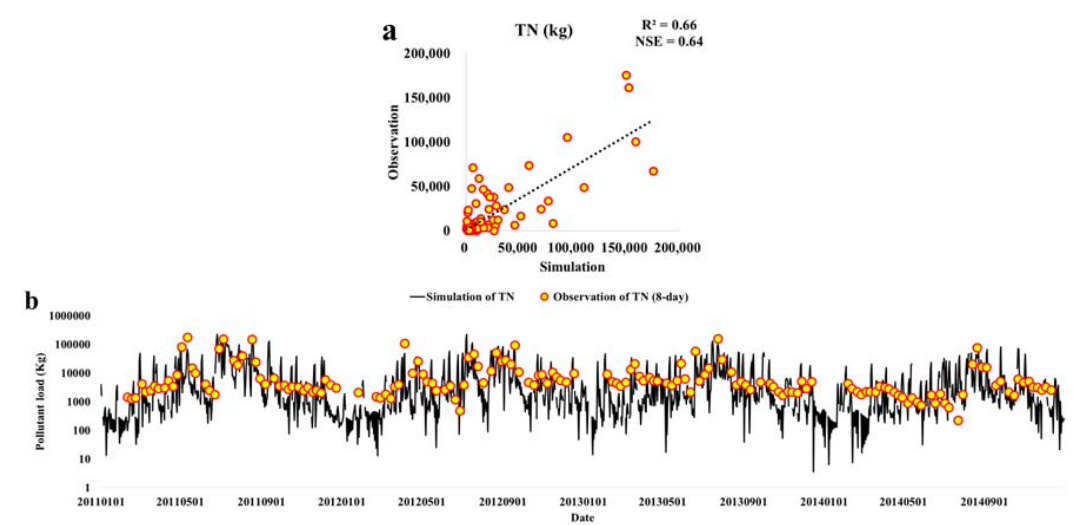
Figure 6. Comparison between simulated TN ( a ) and observed TN ( b ) at Dalcheon A watershed (2011–2014).